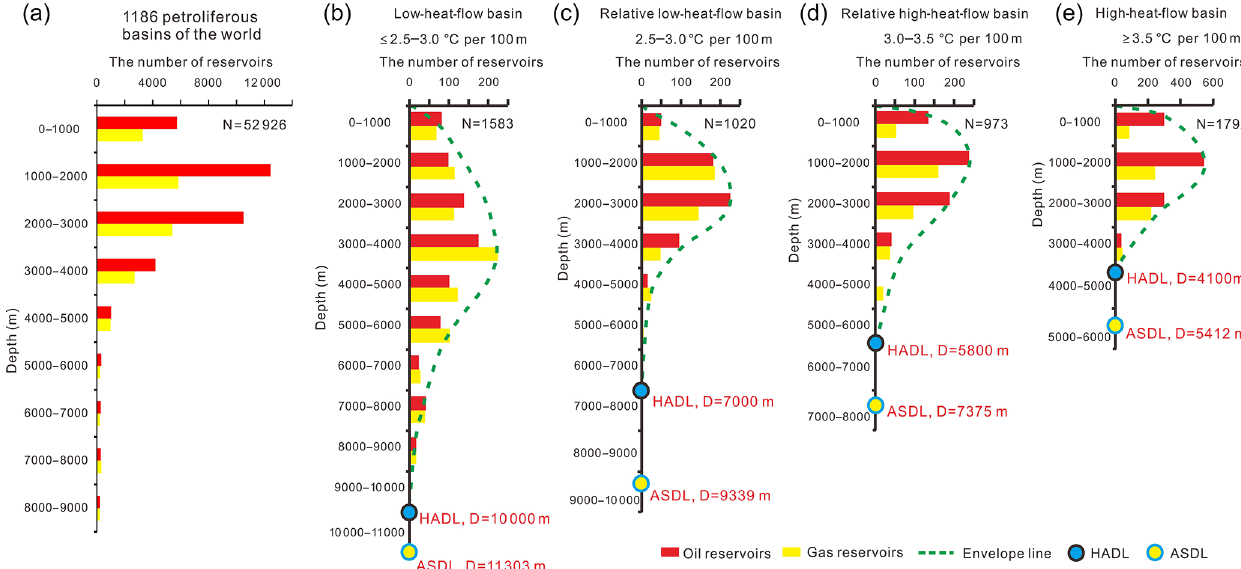
Figure 8. The vertical distribution of numbers of discovered hydrocarbon reservoirs and their relationships with ASDLs and HADLs in the worldwide 1186 petroliferous basins. (a) Summation of proven reservoirs in the 1186 basins. (b) Low-heat-flow basins ( < 25mWm − 2 ). (c) Relative low-heat-flow basins (25–40mWm − 2 ). (d) Relative high-heat-flow basins (40–55mWm − 2 ). (e) High-heat-flow basins (55– 70mWm − 2 ). The intercept of the green dashed line on the vertical axis marks the HADL. The ASDL, shown in this figure, of each kind of basin with different heat flow is predicted by using the equation shown in Fig.